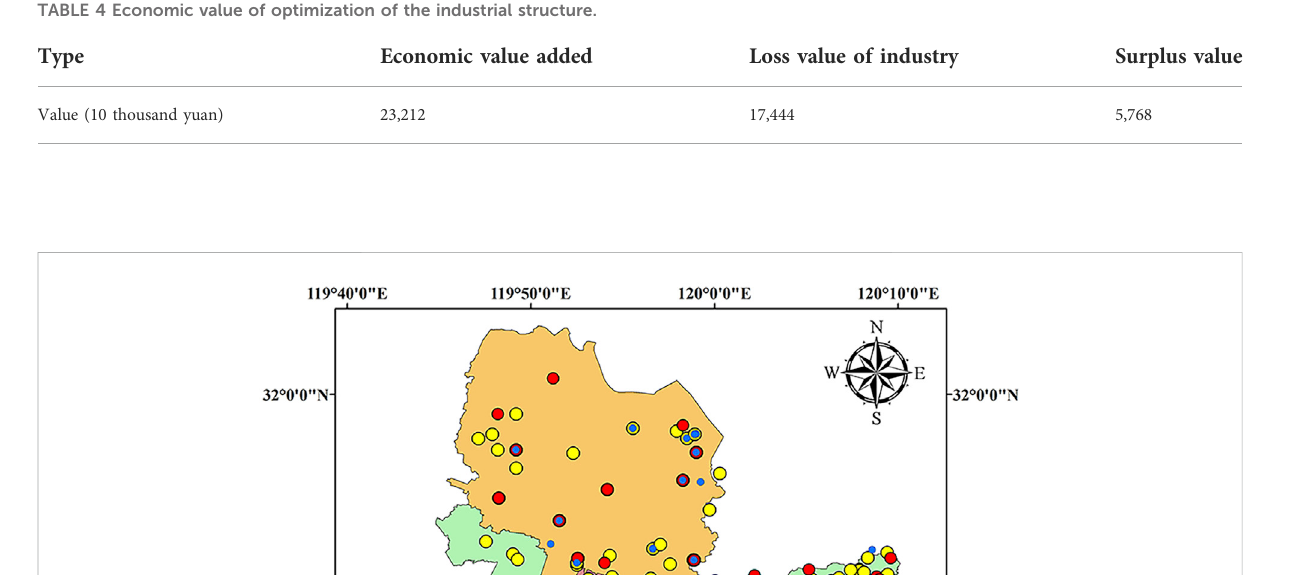
TABLE 4 Economic value of optimization of the industrial structure.